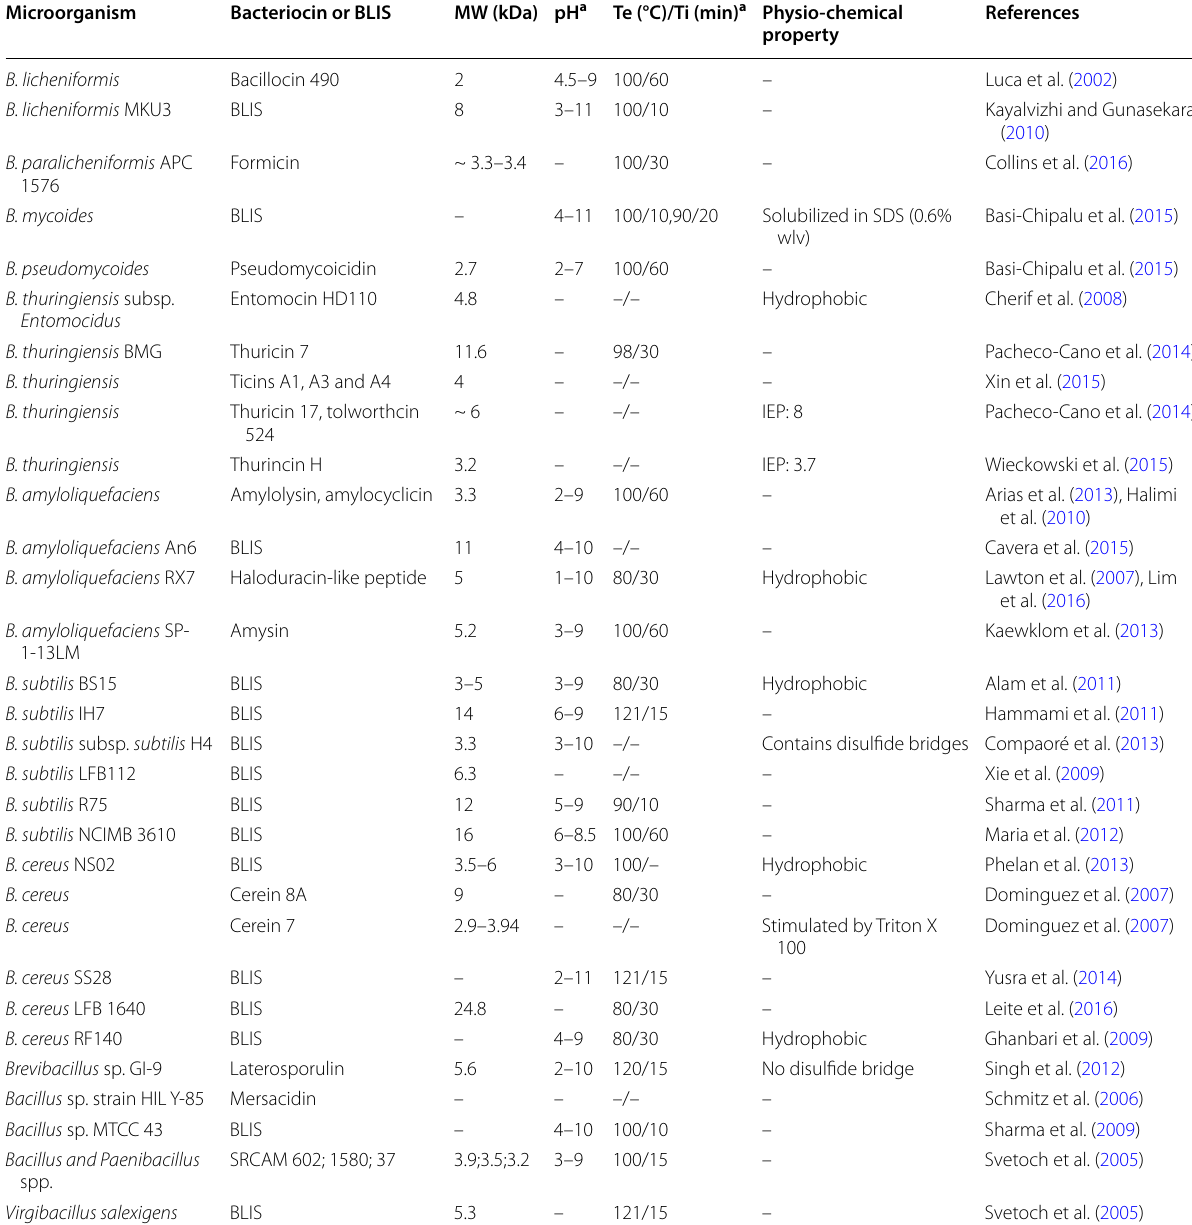
Table 5 Characterization of Bacillaceae bacteriocins based on their molecular mass and stability towards pH, heat as well as their other physio-chemical